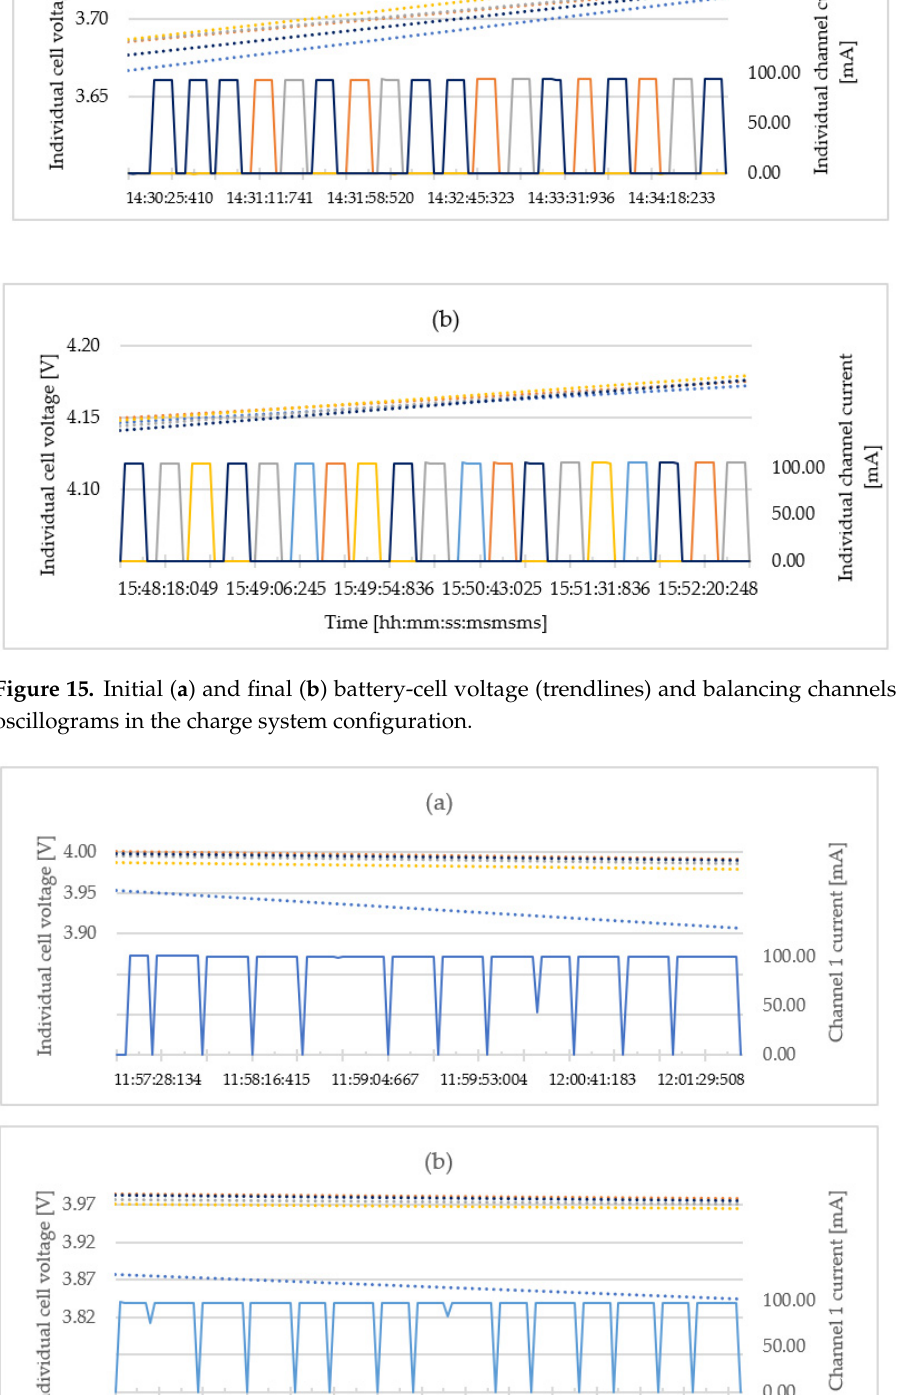
Figure 17. Initial ( a ) and final ( b ) battery ‐ cell voltage (trendlines) and balancing channels current oscillograms in the discharge system configuration.